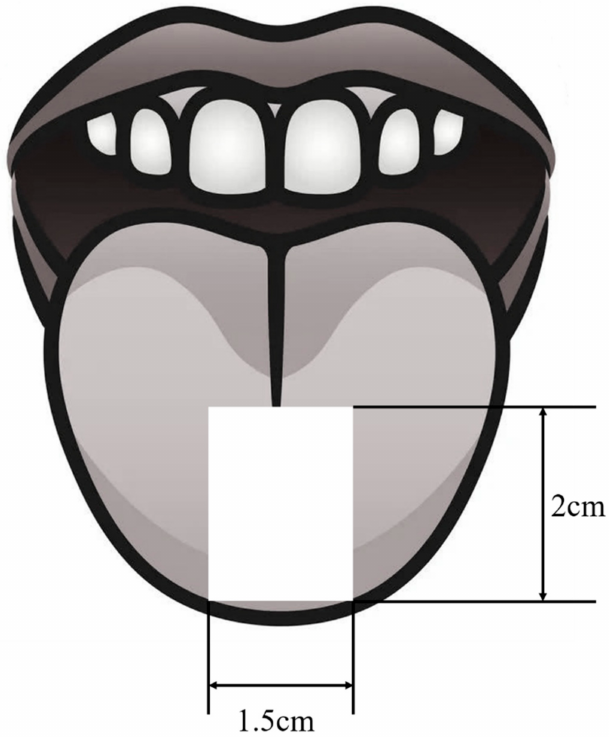
Figure 3. Stimuli